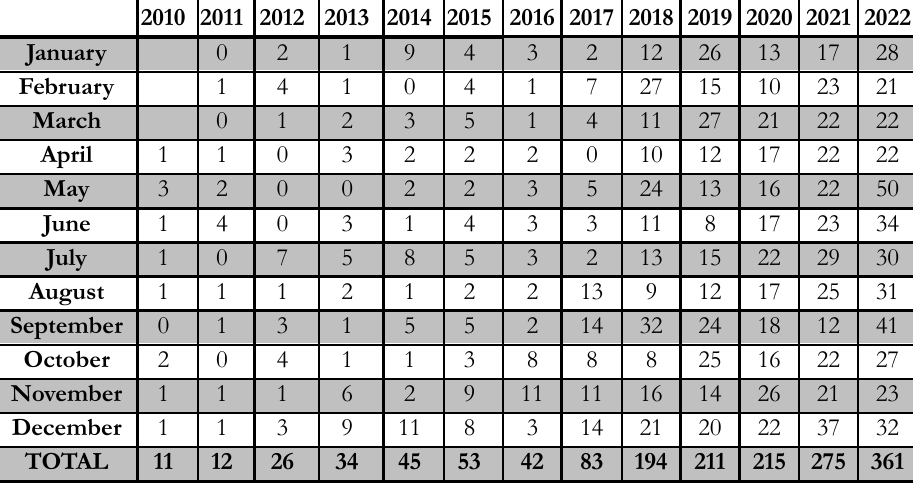
Table 1. Article submissions evolution from 2010 to 2022